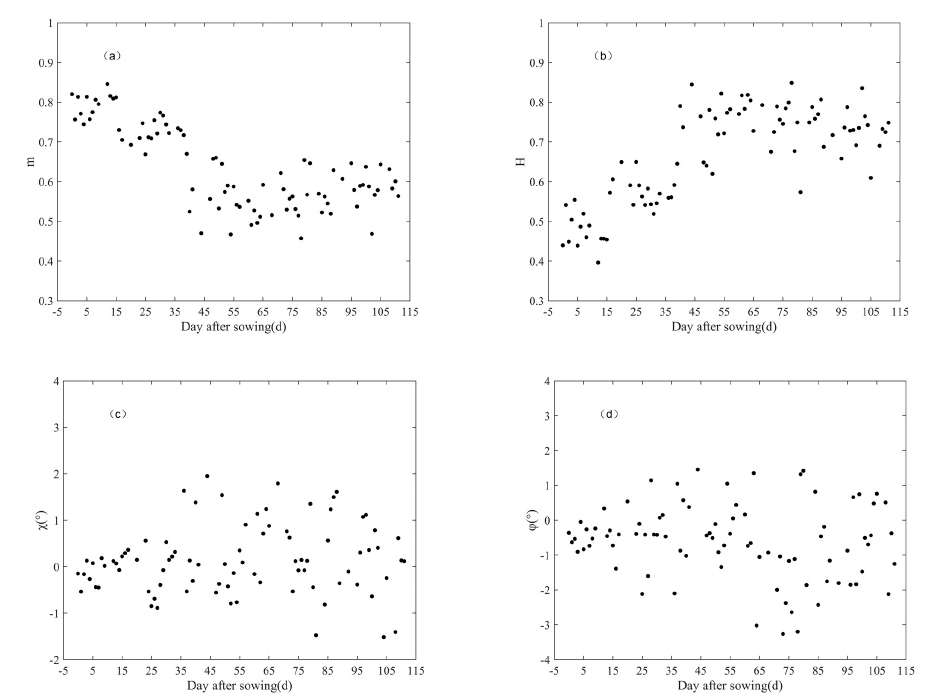
Figure 7. The evolution of m , H , χ and ϕ in Group 2 versus rapeseed phenology.